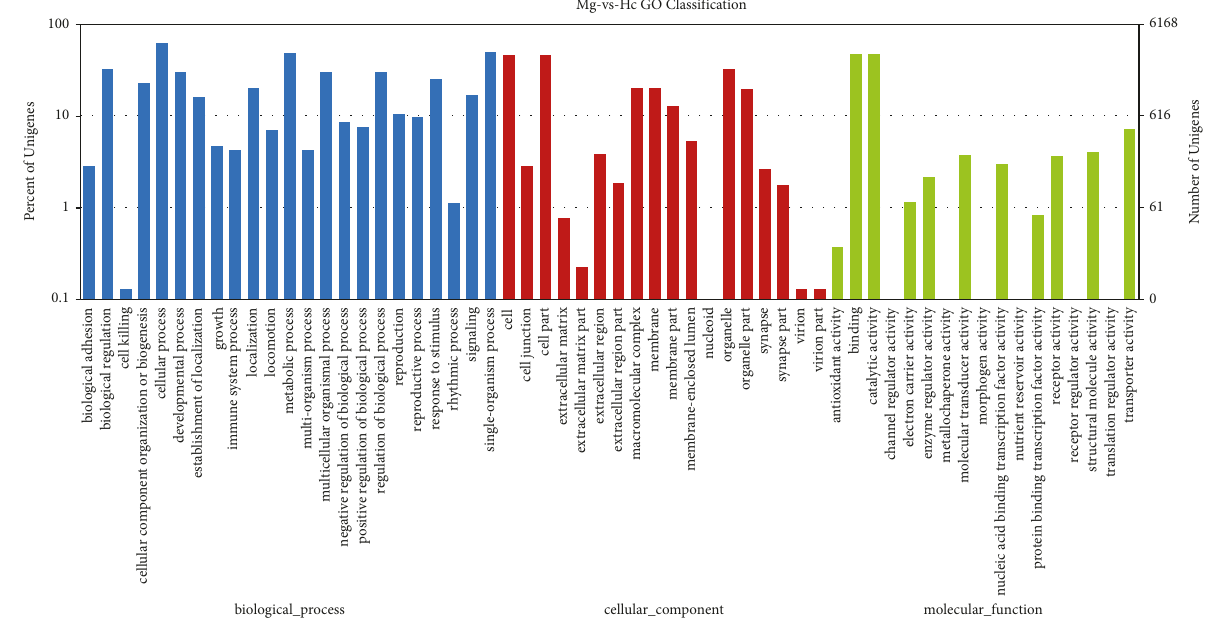
Figure 4: Gene Ontology (GO) classification of Helicoverpa assulta